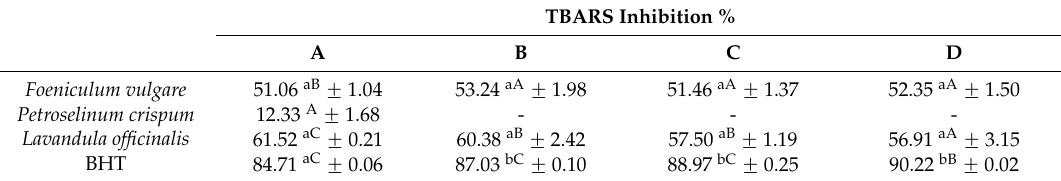
Table 5. Antioxidant activity of organic fennel, parsley, and lavender essential oils from Spain using the corresponding concentrations (A = 5 g/L, B = 10 g/L, C = 20 g/L, D = 50 g/L) measured by TBARS assay.